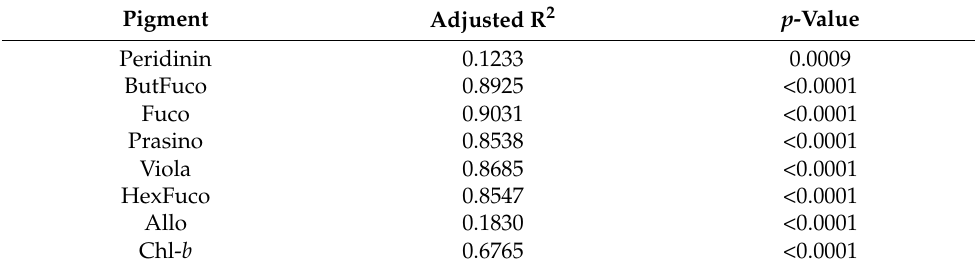
Table 4. p -values and adjusted R 2 values of multiple linear regression